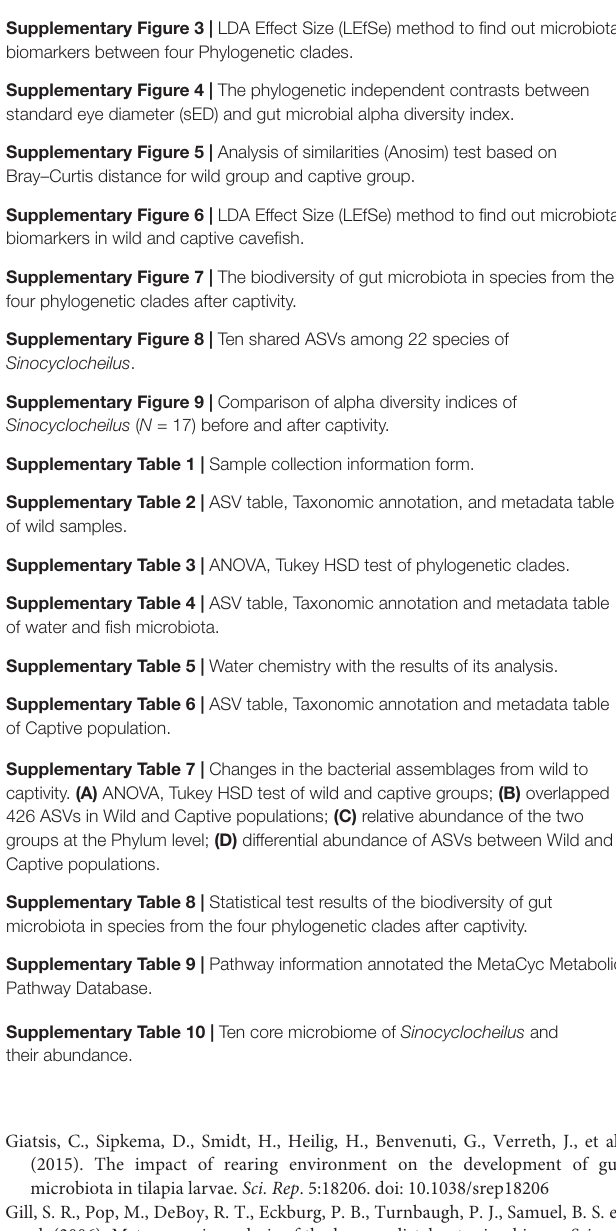
Supplementary Figure 2 | Microbial composition of Sinocyclocheilus species. (A) Order level. (B) Genus level. Different colors in the figures indicate the different